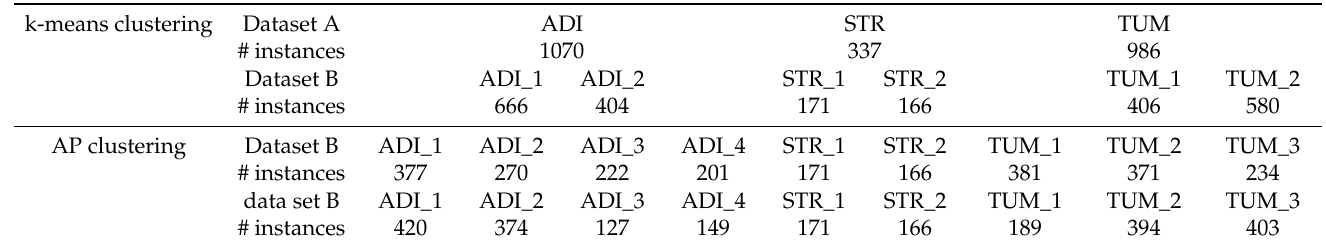
Table 5. The number of instances in original classes and after class decomposition of the colorectal cancer dataset using k-means and AP clustering algorithms.